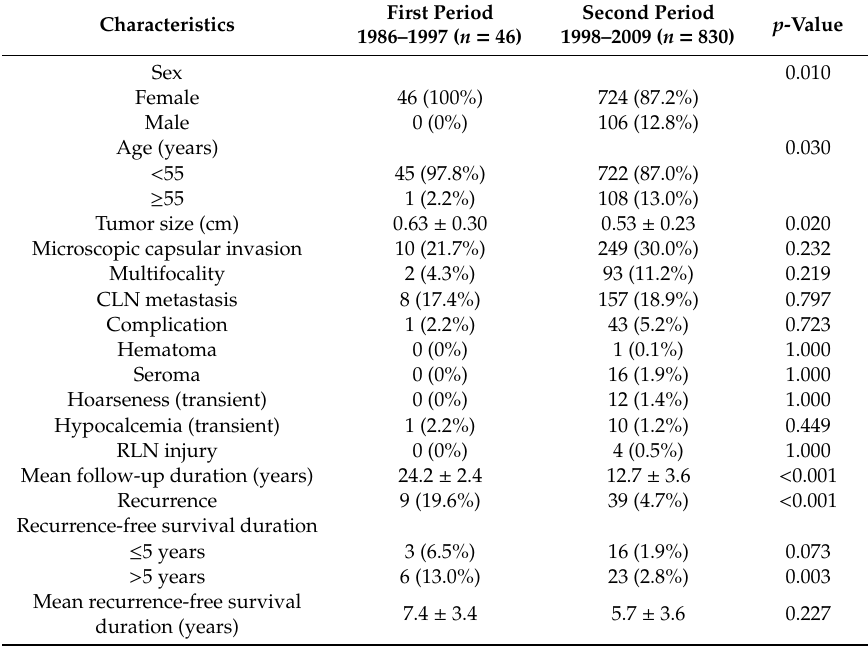
Table 5. Comparison characteristics of the enrolled patients in two